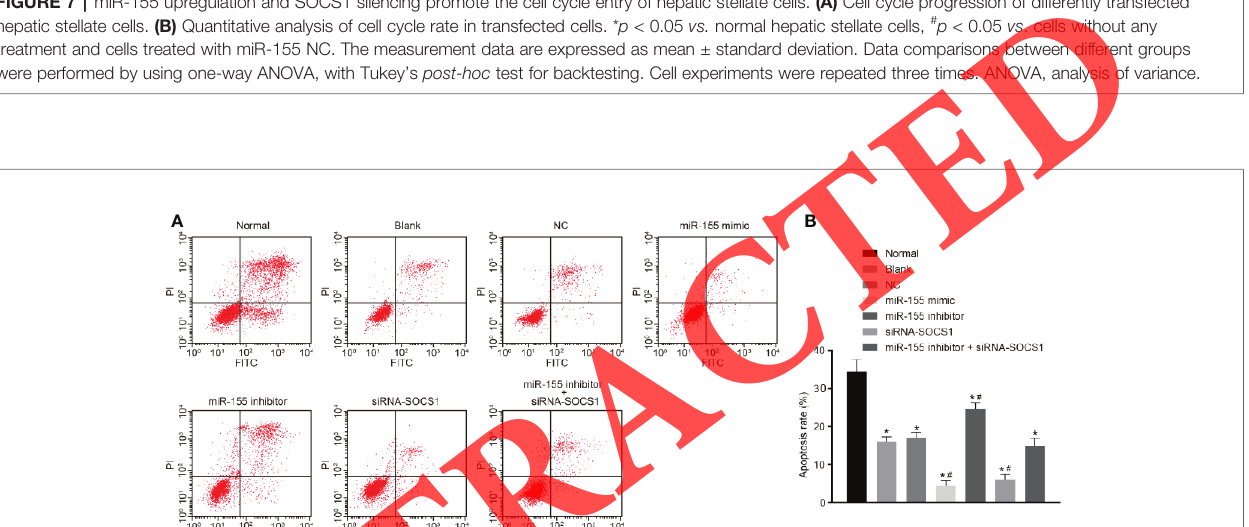
FIGURE 8 | miR-155 upregulation and SOCS1 silencing repress hepatic stellate cell apoptosis. (A, B) Cell apoptosis abilities in cells without any treatment and cells treated with miR-155 NC. * p < 0.05 vs. normal hepatic stellate cells, # p < 0.05 vs . cells without any treatment and cells treated with miR-155 NC. The measurement data are expressed as mean ± standard deviation. Data comparisons between different groups were performed by using one-way ANOVA, with Tukey ’ s post-hoc test for backtesting. Cell experiments were repeated three times. ANOVA, analysis of